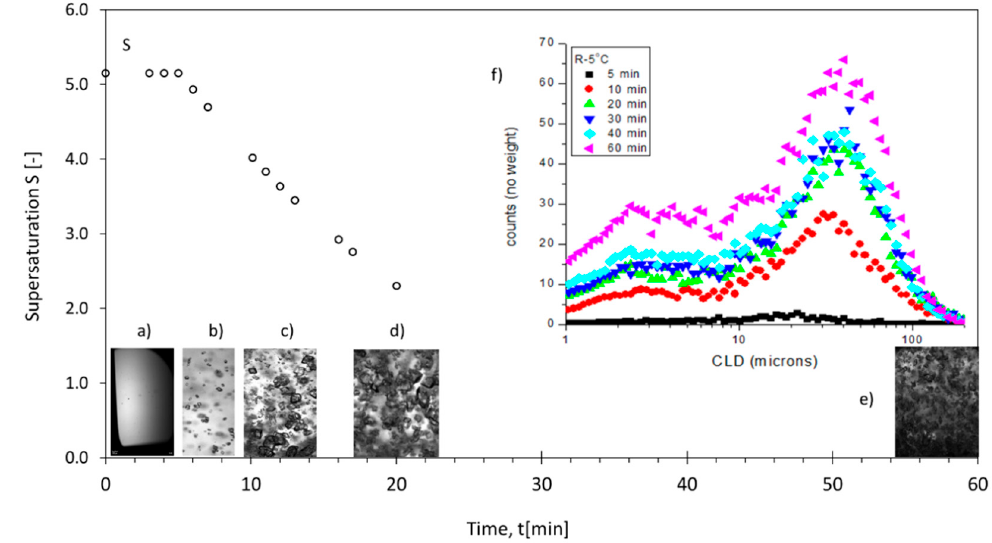
Figure 2. Supersaturation S, crystal/solution images and CLD for a reaction isotherm of 5 ◦ C as a function of time at ( a ) 1.44 min, ( b ) 5 min, ( c ) 10 min, ( d ) 20 min, ( e ) 60 min and ( f )